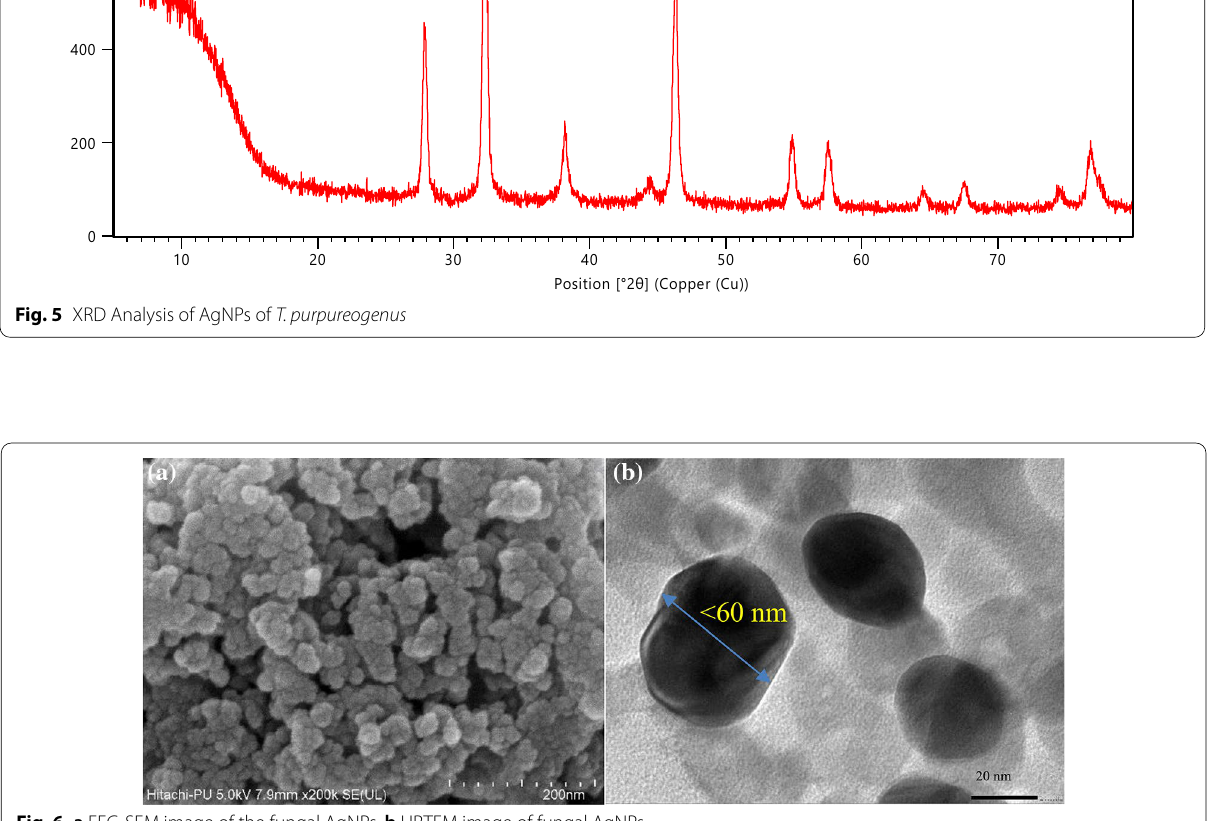
Fig. 6 a FEG-SEM image of the fungal AgNPs. b HRTEM image of fungal AgNPs